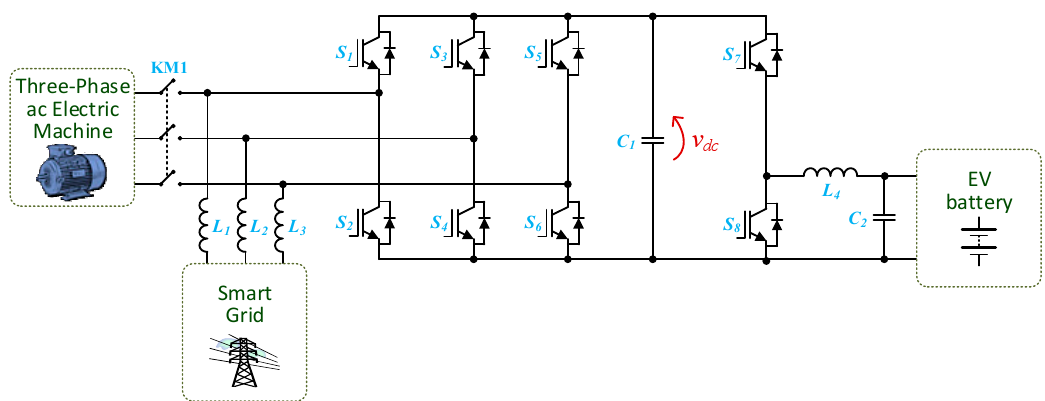
Figure 24. Unified power converter topology based on the disconnection of the three-phase ac electric machine.